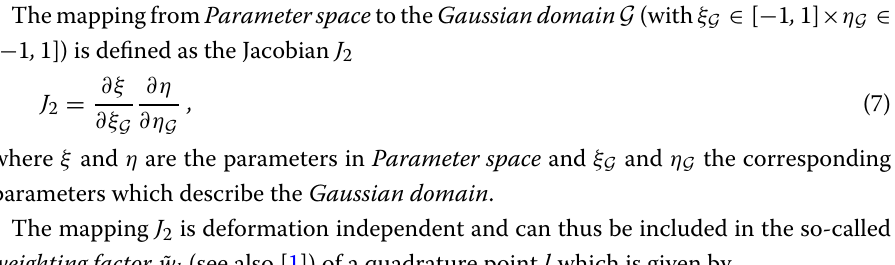
The mapping from Parameter space to the Gaussian domain G (with ξ G ∈ [ − 1 , 1] × η G ∈ [ − 1 , 1]) is defined as the Jacobian J